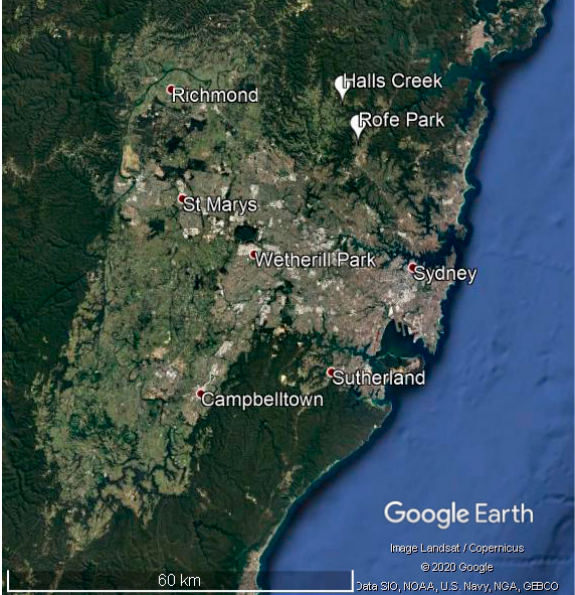
Figure 1. The location of the field sampling sites relative to areas within the Greater Metropolitan Region of Sydney, NSW, Australia.